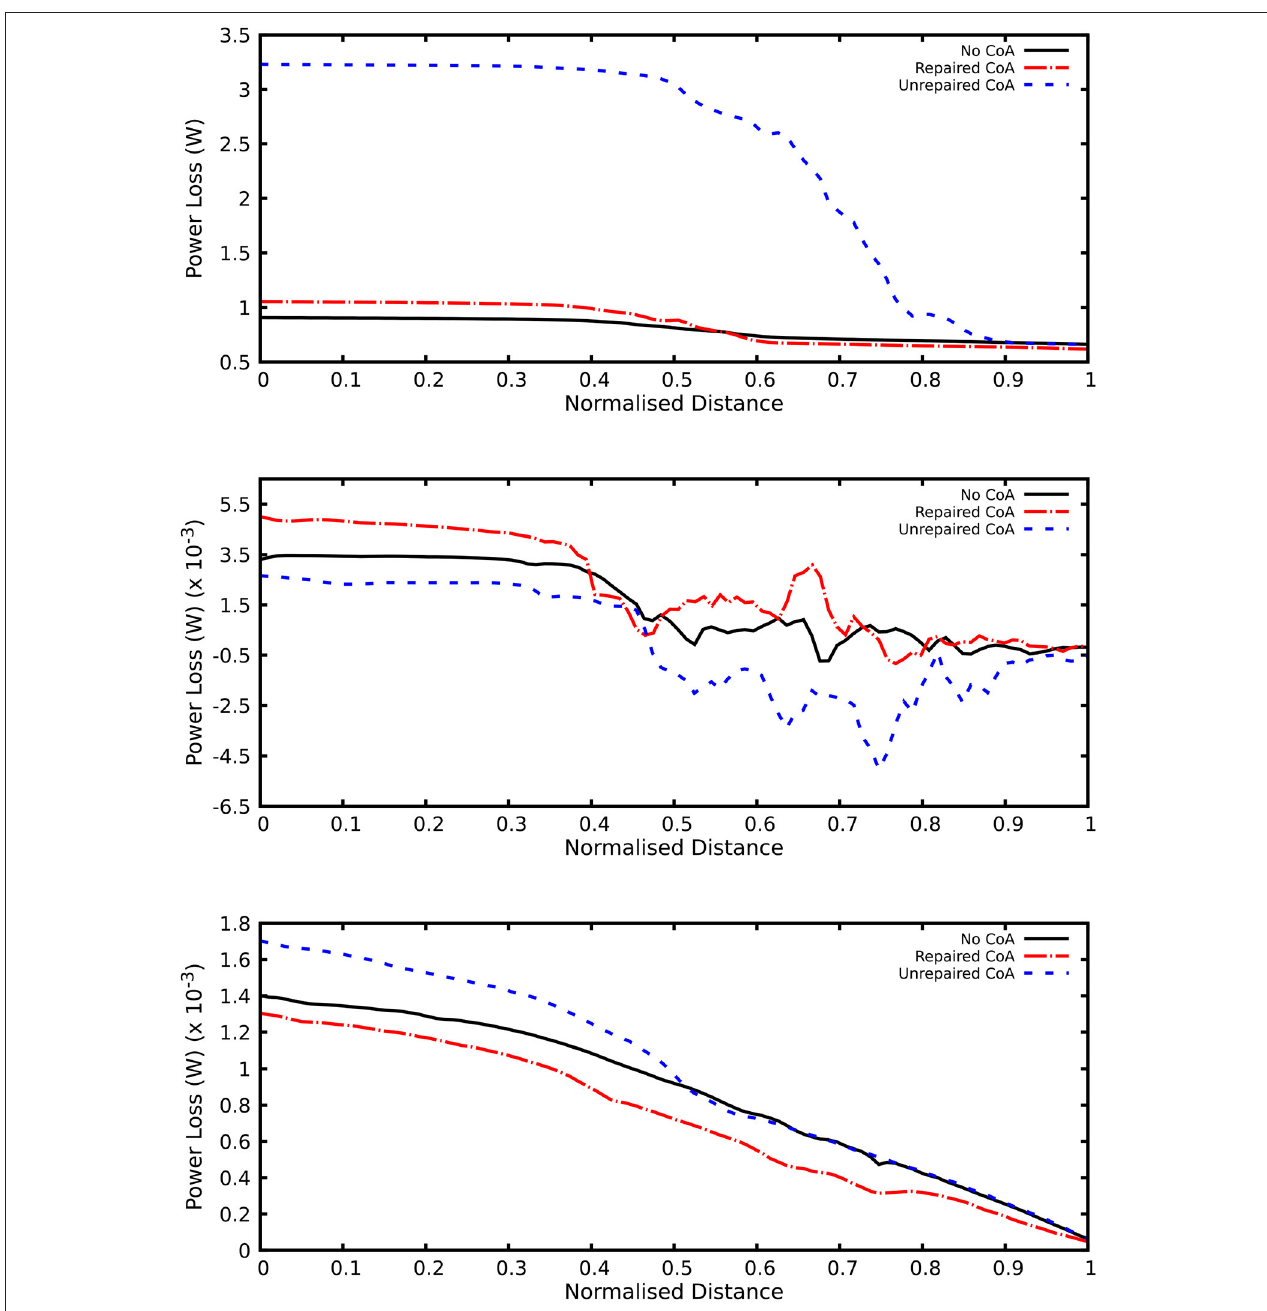
FIGURE 7 | Plot of power loss along the aorta. Order of plots from top to bottom: end systole, peak systole, and end